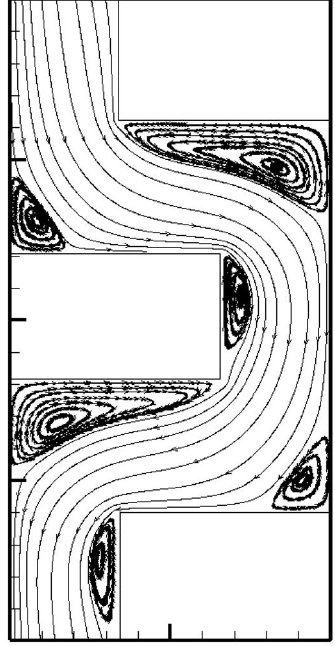
Figure 8. Streamline pattern of steady flow in the multiple right bending